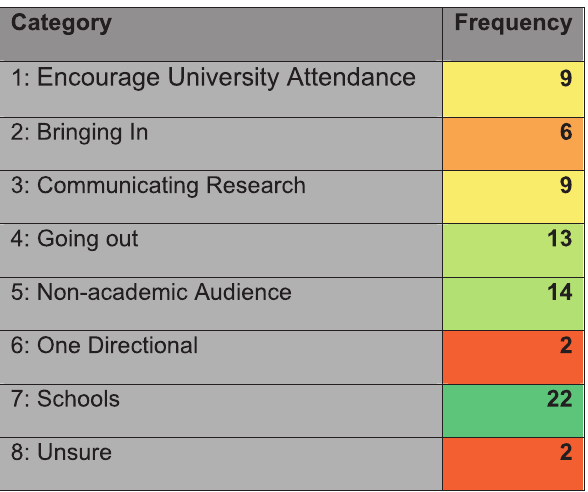
Figure 2. Major categories for ‘definitions of outreach’ and frequencies; listed in alphabetical order and colour coded according to frequency.